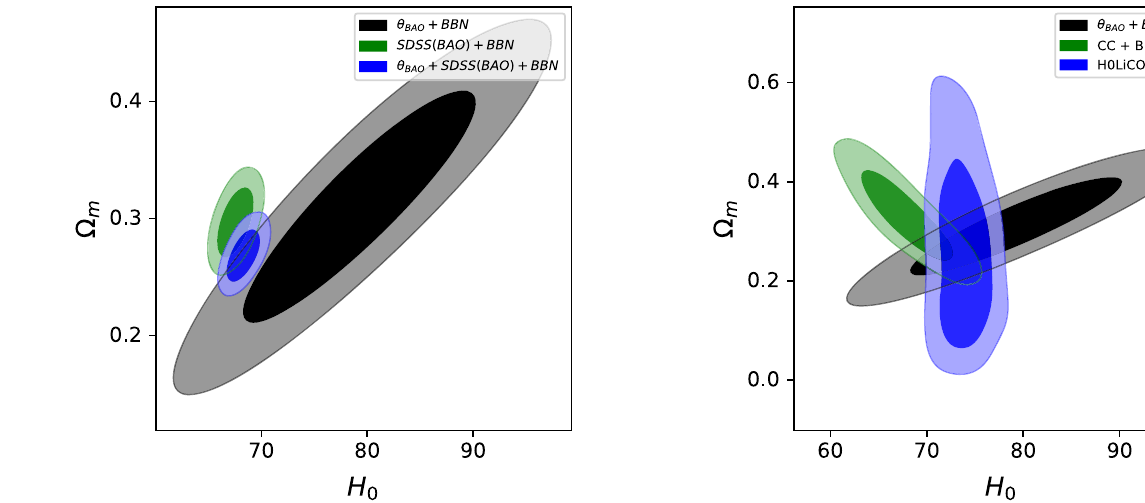
Fig. 4 Parametric space in the H 0 − (cid:3) m plane inferred from θ BAO + BBN, SDSS (BAO) final release + BBN, and θ BAO + SDSS (BAO) final release + BBN joint analyses. The H 0 parameter is measured in units of km s − 1 Mpc − 1